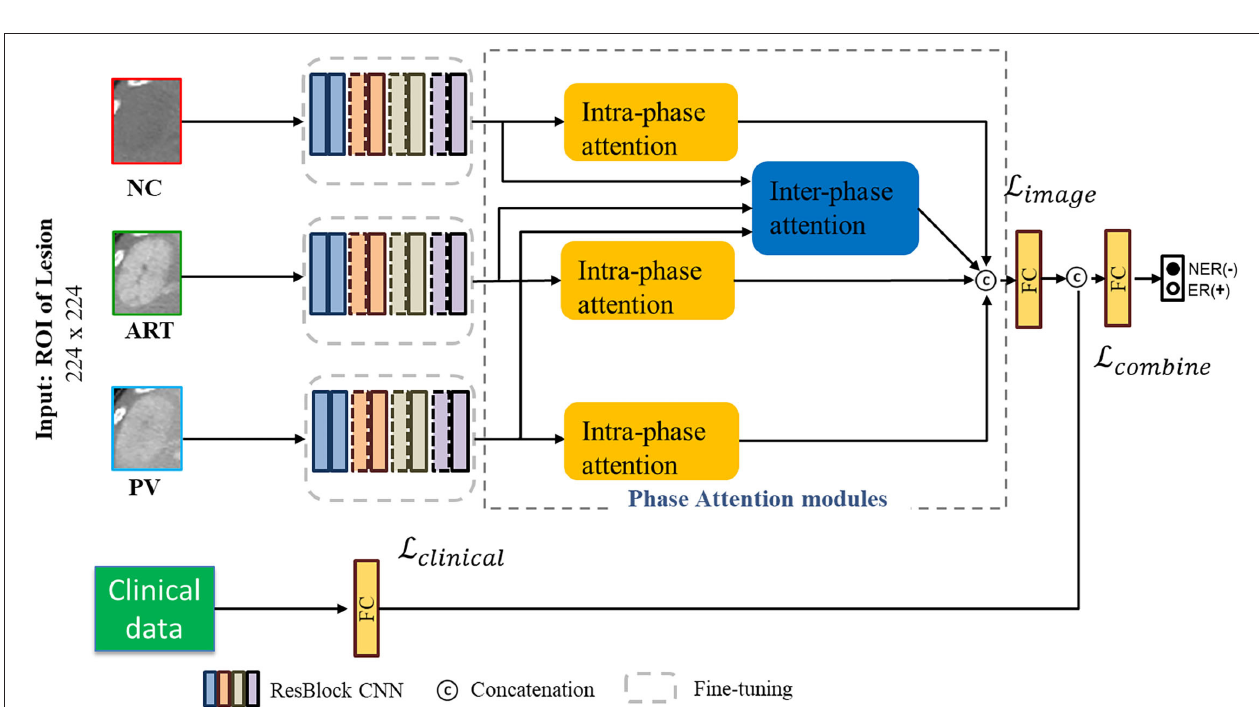
FIGURE 2 | Workflow of the DPA model for joint image data and clinical data. The image pathway consists of three residual CNN blocks and two phase-attention modules. Deep image features are derived from these two components and fed into the fully connected (FC) layer. Clinical data are passed through an FC layer and then concatenated with image features to pass through a final FC layer for early recurrence prediction of HCC.